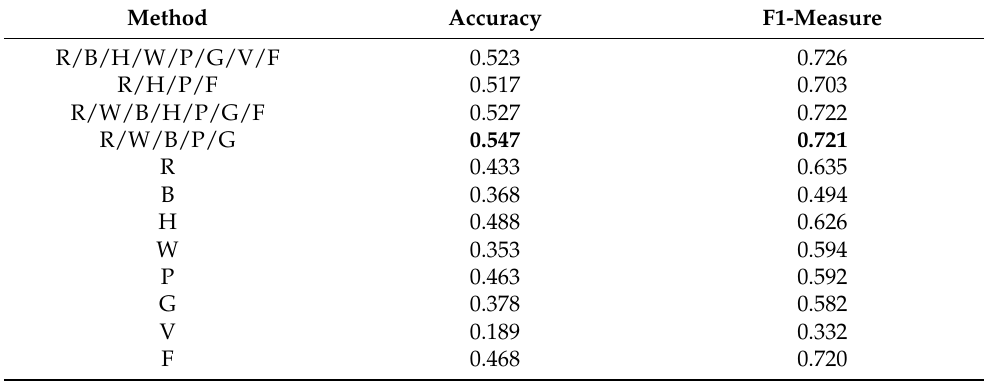
Table 9. Generalization performance on the two different data sets. The BU-3DFE and JAFFE data sets were used for training and testing, respectively. Best feature results are in bold